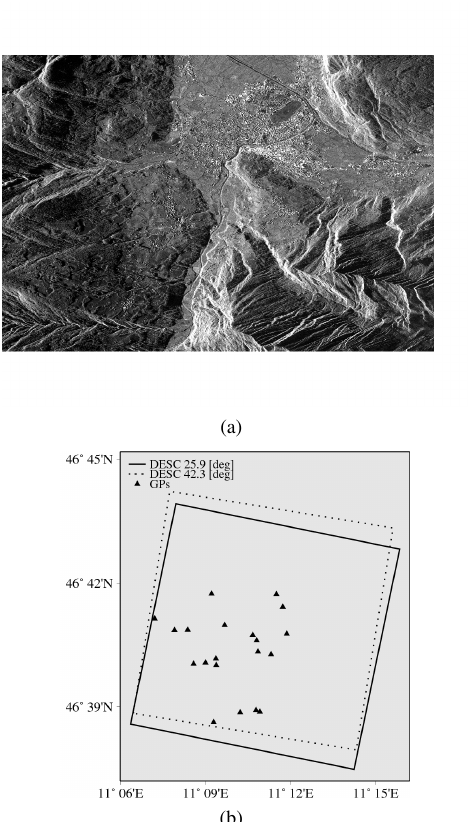
Figure 1: Merano Data set and COSMO-SkyMed SpotLight stereo pair